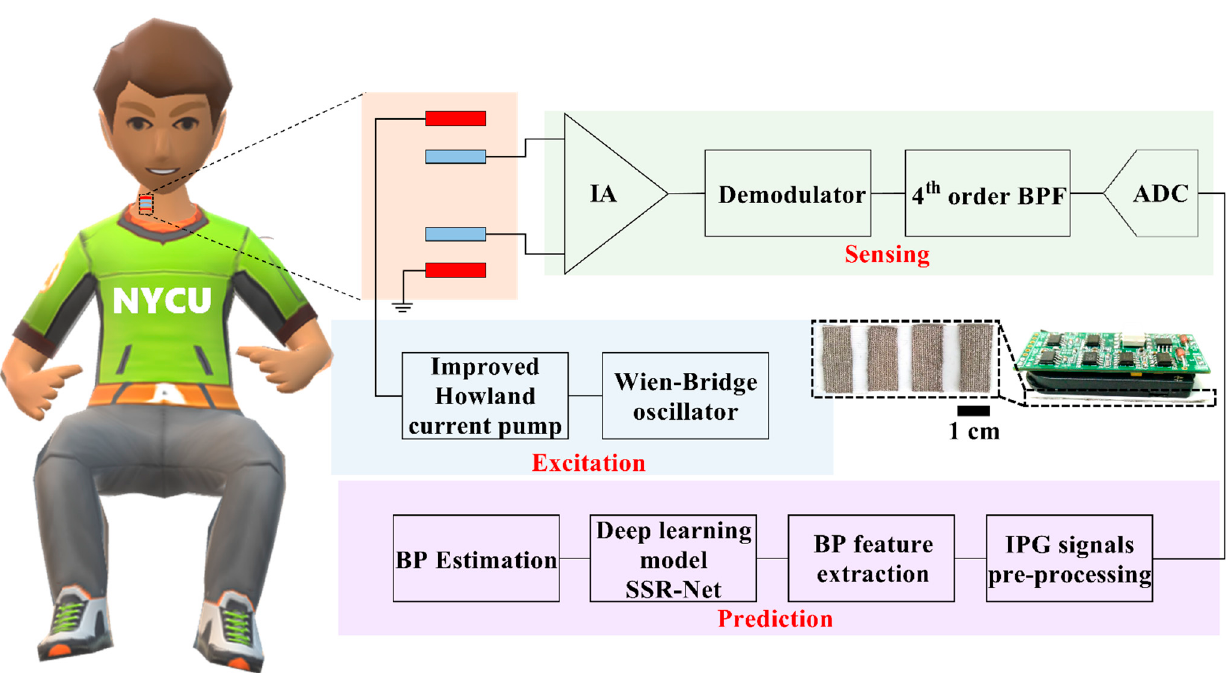
Figure 2. Schematic of the proposed proof-of-concept wearable intelligent bio-impedance system for continuous BP monitoring, including IPG sensing, IPG excitation functions, and AI-based BP estimation.